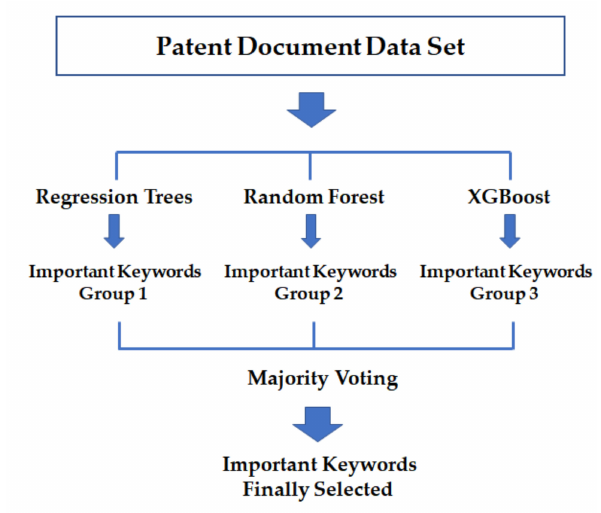
Figure 2. Proposed ensemble model of important keyword selection.